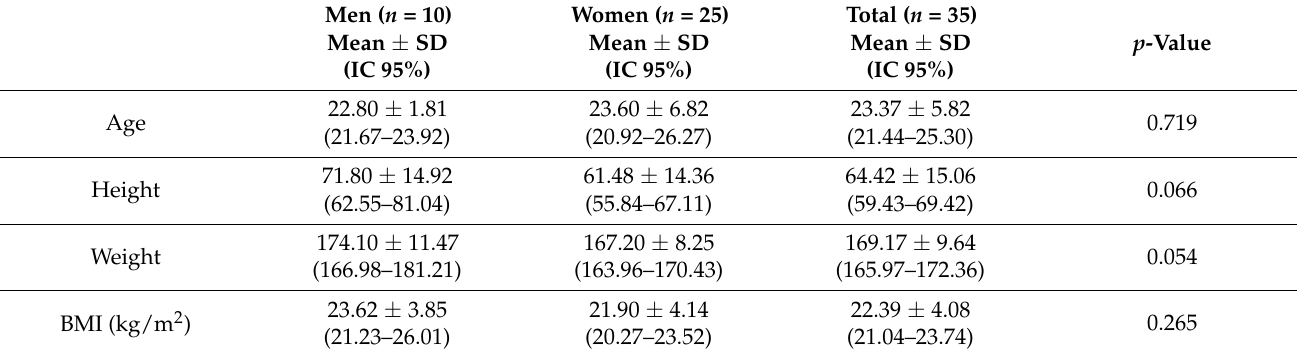
Table 2. Sociodemographic characteristics of the study